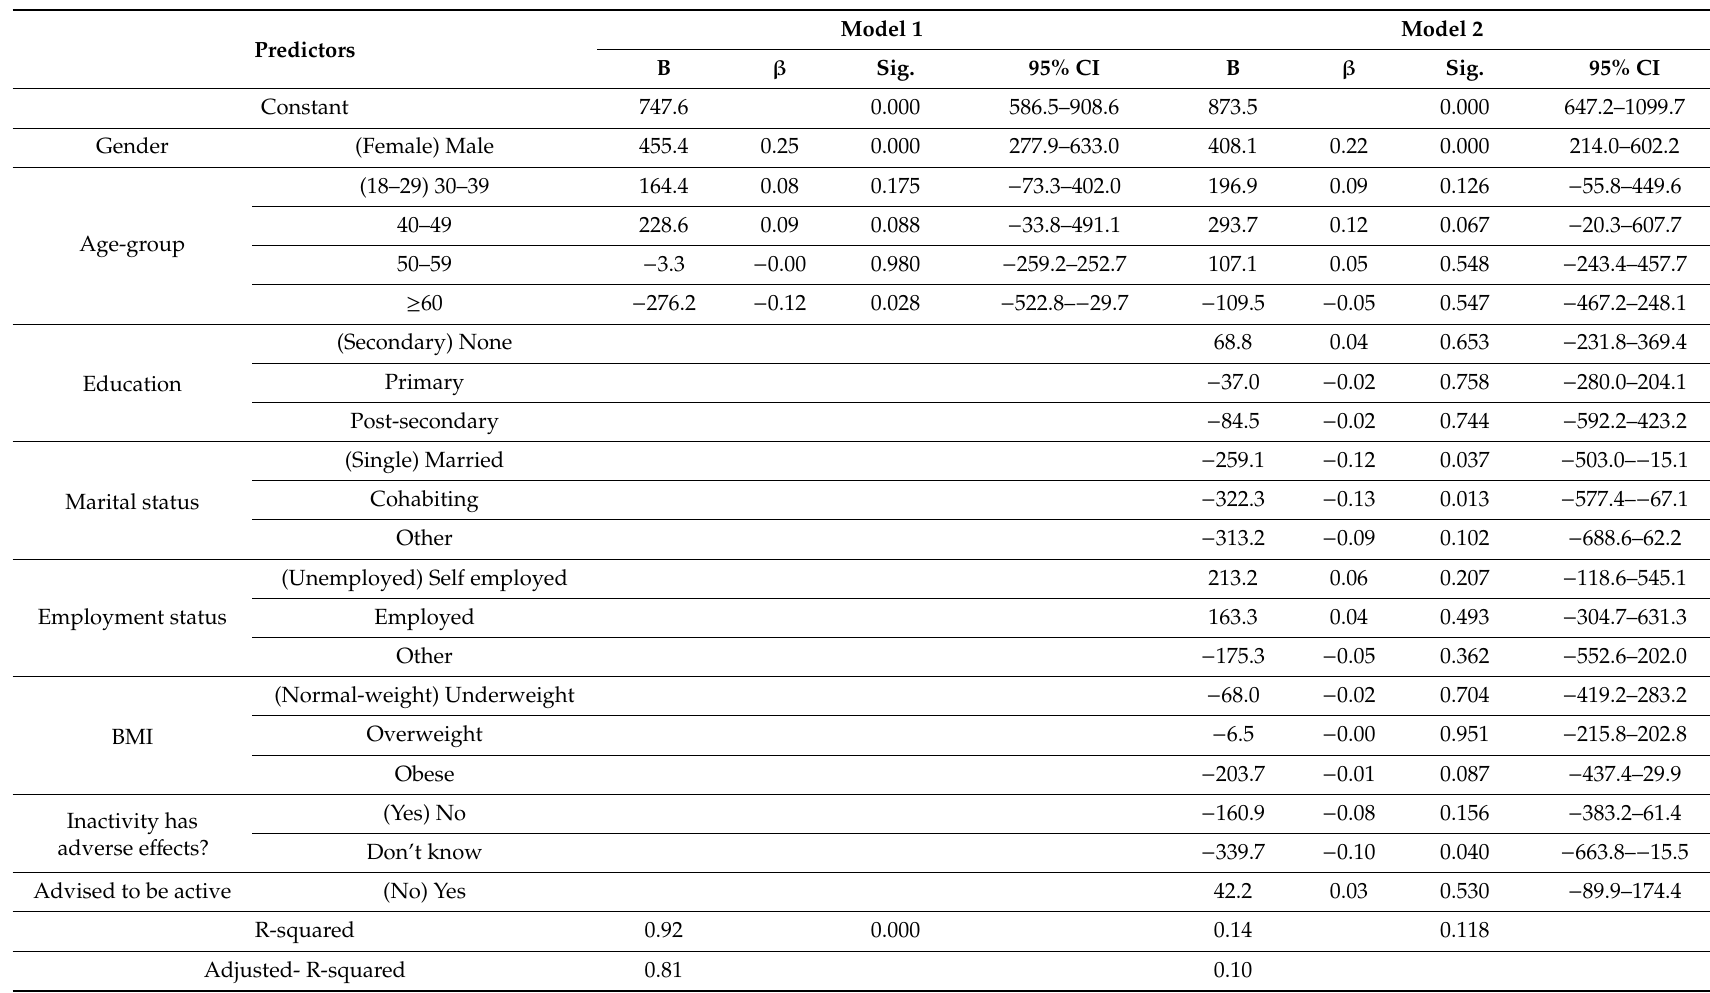
Table 3. Results of hierarchical linear regression on time spent on physical activity in Ingwavuma ( N =